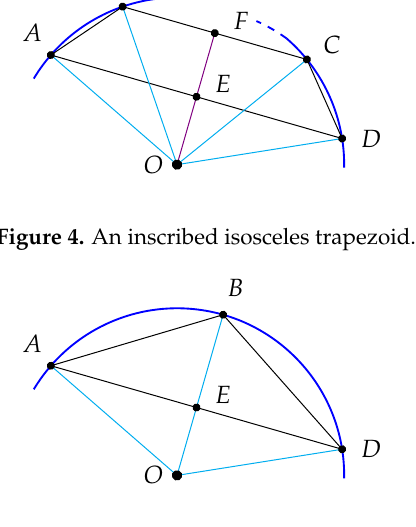
Figure 5. A degenerate inscribed isosceles trapezoid.